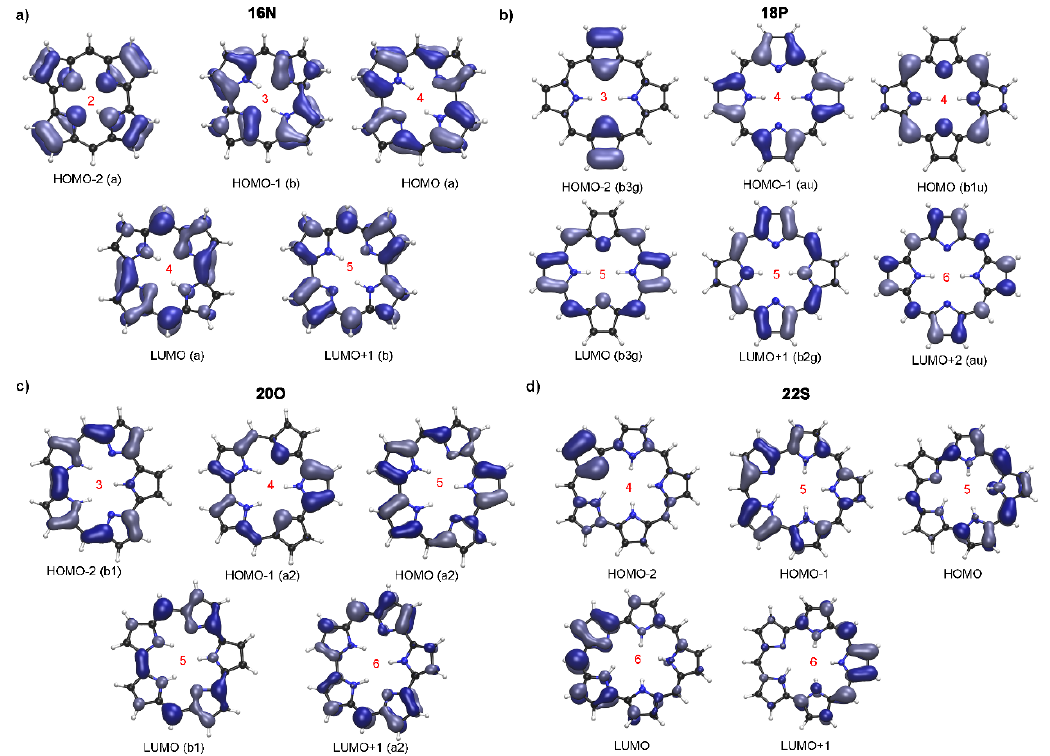
Figure 8. Molecular orbitals for aromatic and antiaromatic Hückel porphyrinoids: ( a ) (16)norcorrole, ( b ) (18)porphyrin, ( c ) (20)orangarin, ( d ) (22)smaragdyrin. The values in red indicate the number of nodal planes in each orbital.